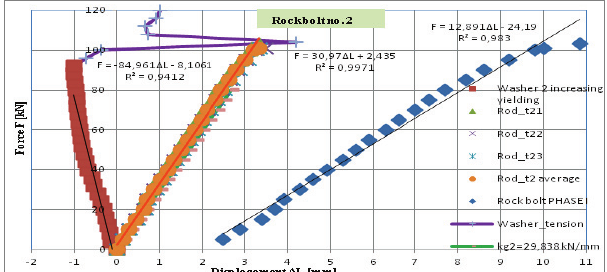
Fig. 19. The detailed loading characteristics for the components of the rock bolt support No.